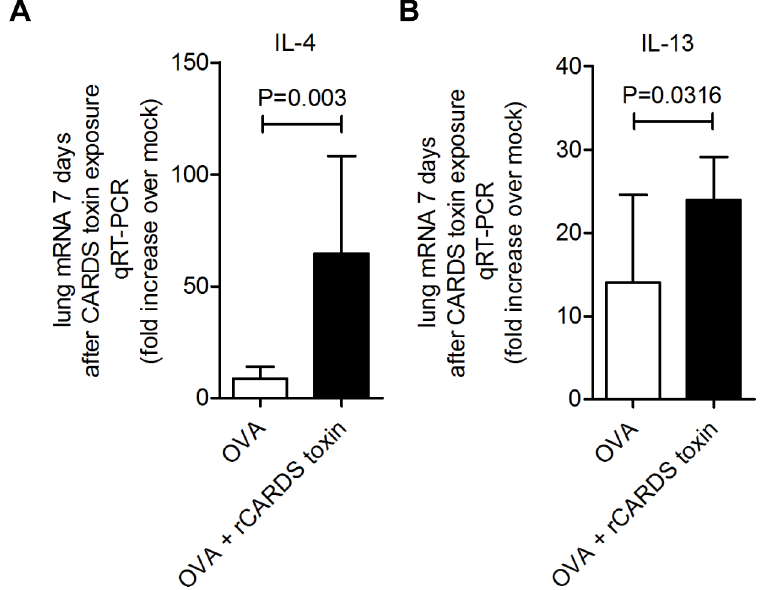
Figure 3. rCARDS toxin increases the induction of Th2 effector cytokines in OVA treated mice. RNA was extracted from lungs of OVA- or OVA + rCARDS toxin-treated mice. qRT-PCR quantification of mRNA induction for A) IL-4 (p=0.003) and B) IL-13 (p=0.0316) 7 days after